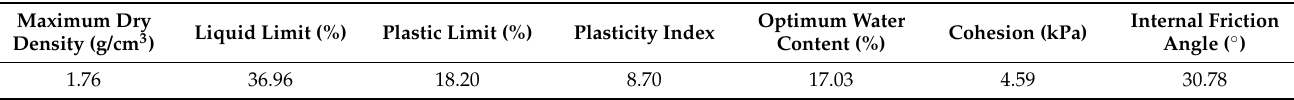
Table 1. Basic material parameters of subgrade